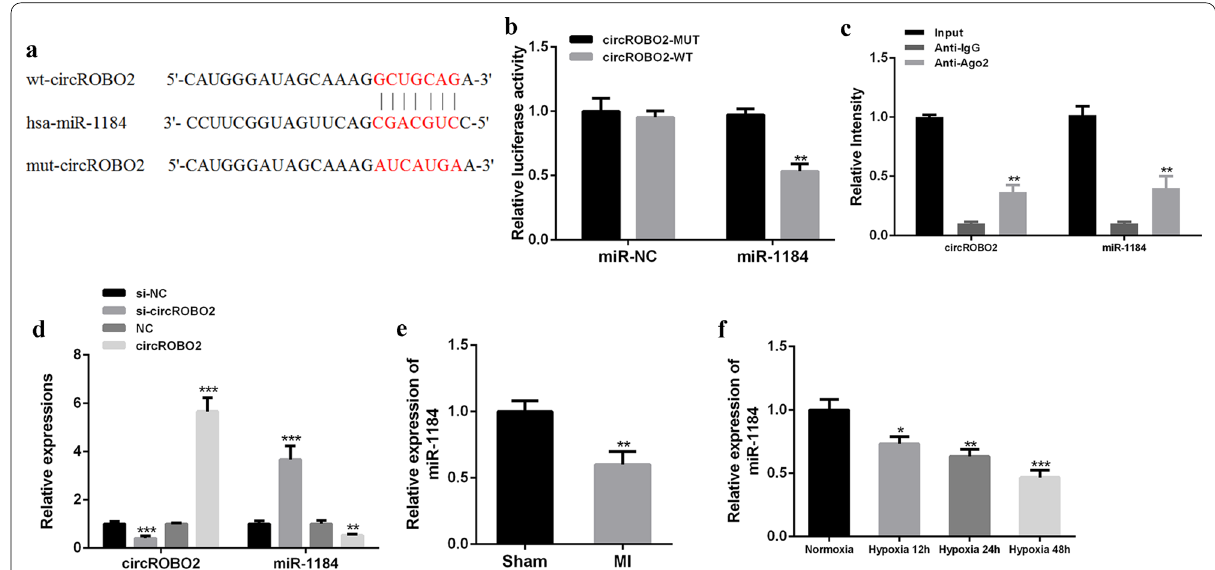
Fig. 2 CircROBO2 played a biological role through miR‑1184. a Circ Interactome predicted the putative targeting sites for circROBO2 and miR‑1184. b Luciferase activity analysis. c The RIP method was used in primary cardiomyocytes. Determine the degree of enrichment of circROBO2 and miR‑1184 RNA in the IP complex. Anti‑immunoglobulin G (IgG) was used as a control. d Knockdown or overexpression of circROBO2 or miR‑1184 in primary cardiomyocytes. e The expression levels of miR‑1184 in ischemic myocardium and normal tissues. f The expression levels of miR‑1184 in myocardial cells of mice exposed to normoxic or hypoxic conditions. All above the experiments were repeated three times. * P < 0.05, ** P < 0.01, *** P <